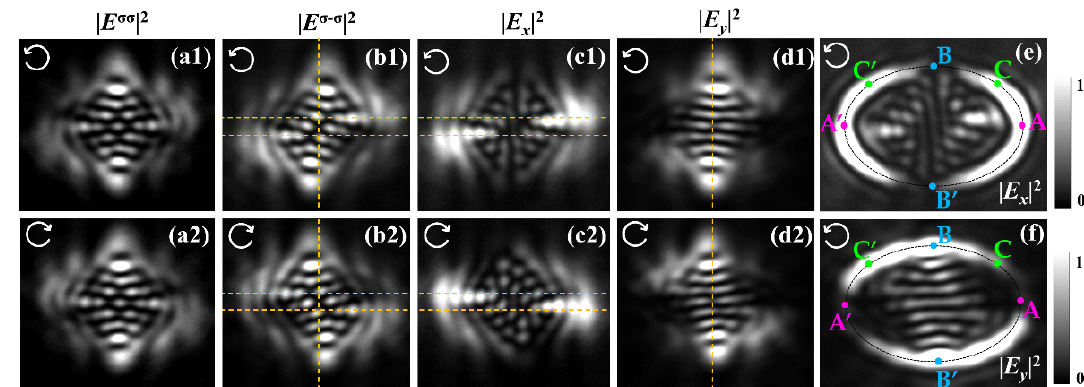
Figure 7. ( a1 – d2 ) Experimental results of different components of transmitted fields with RCP ( a1 – d1 ) and LCP ( a2 – d2 ) illumination at z = 2 µm. ( e – f ) Experimental results of | E x | 2 and | E y | 2 near the gold–air interface under RCP illumination. The incidences are marked with white arrows.